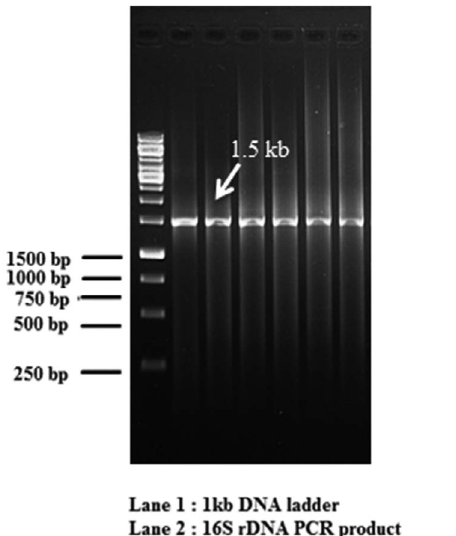
Fig. 3. Agarose electrophoresis of the 16S rDNA PCR amplicons from bacterial